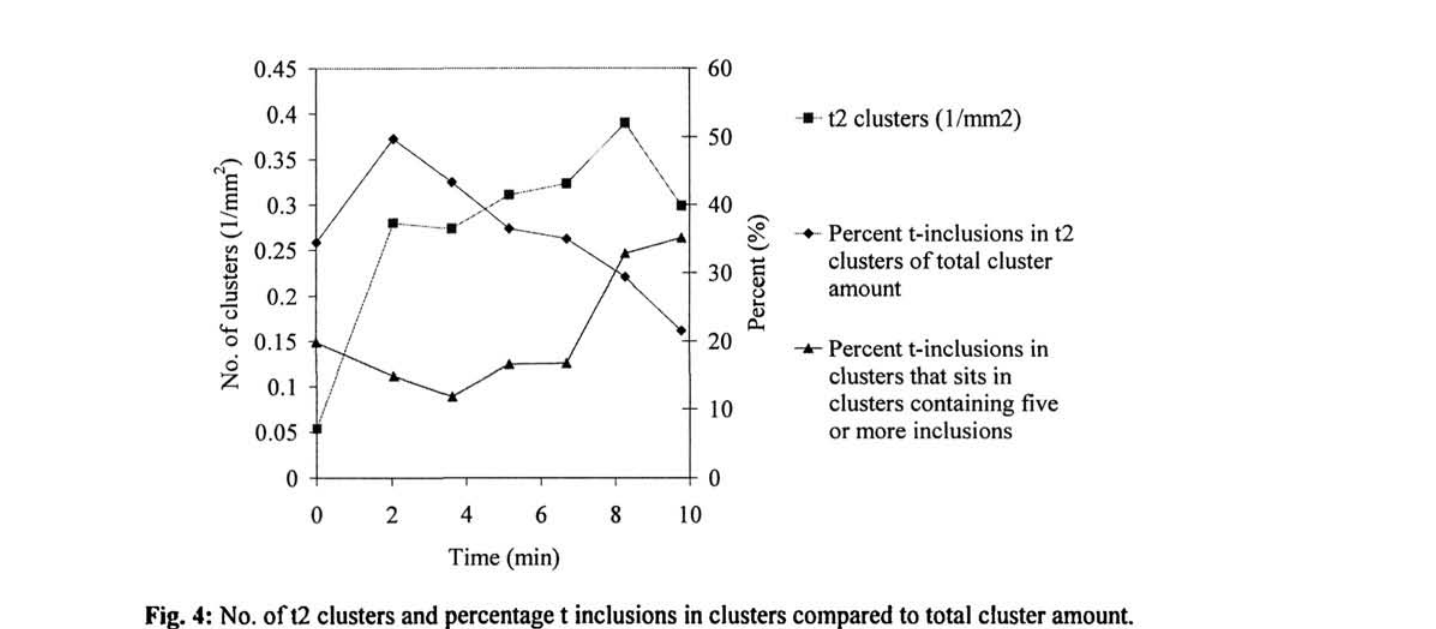
Fig. 4: No. oft?, clusters and percentage t inclusions in clusters compared to total cluster amount.